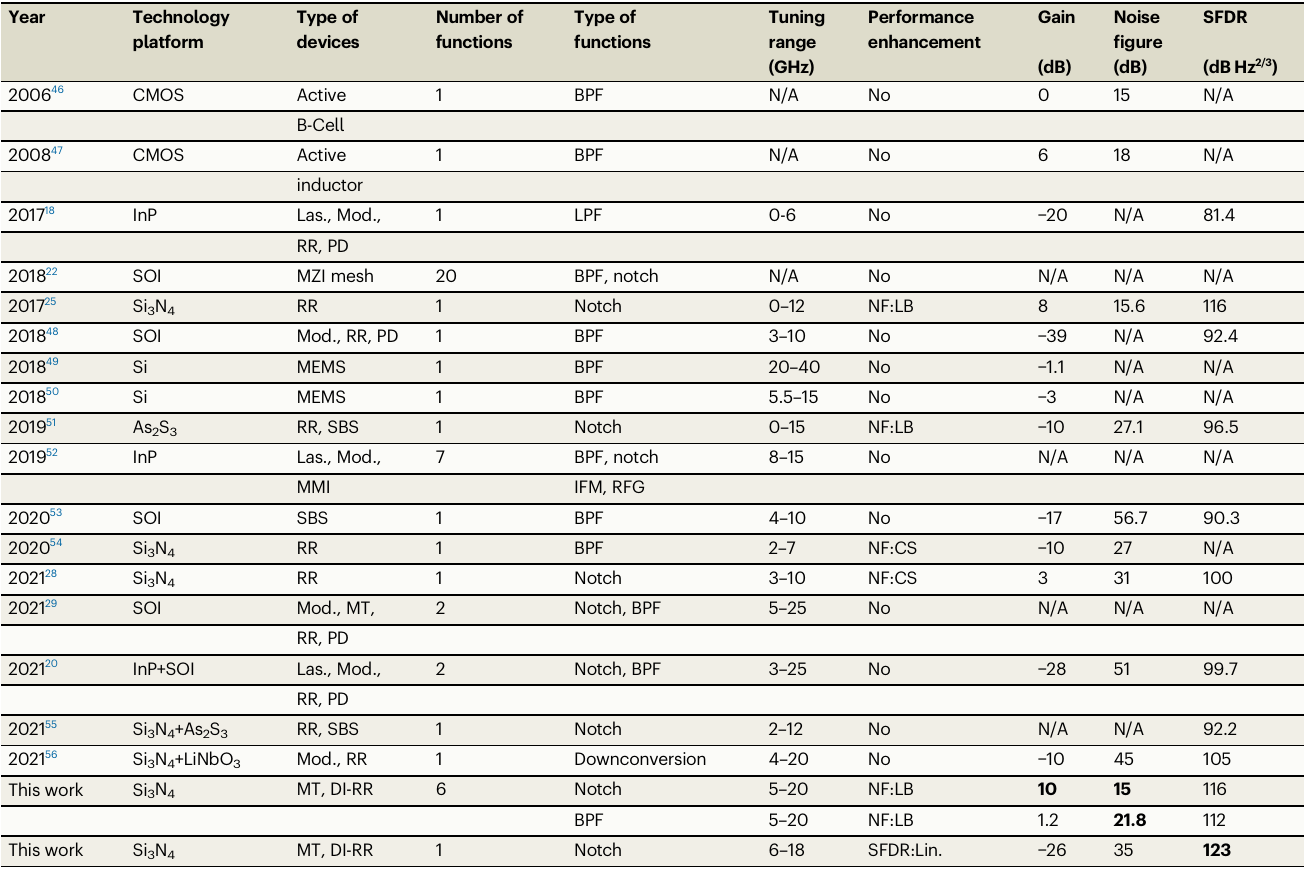
Table 1 | Performance comparison of recon fi gurable fi lter